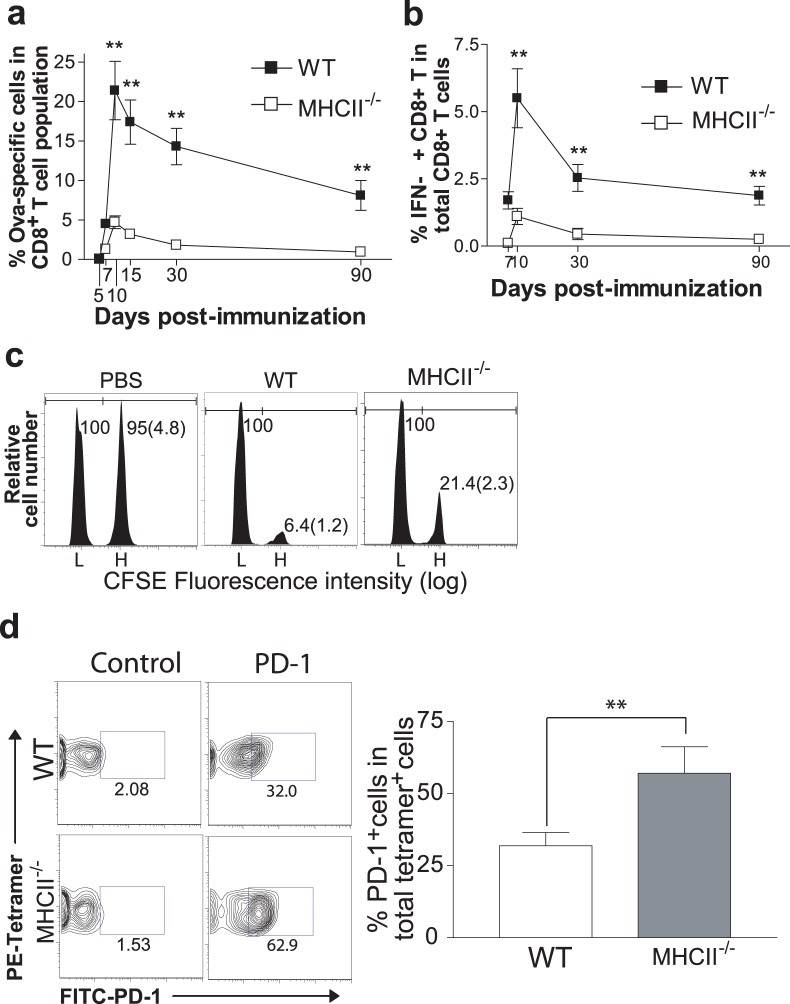
CD4+ T cells impact the kinetics of AdV transgene-specific CTL populations.Following immunization, AdVova-specific CTLs were analyzed in the peripheral blood at different time points by tetramer (a) and intracellular IFN-γ (b) stainings. The values are presented as mean%±SD of OVA-specific tetramer+ CTLs (a) or IFN-γ+ CTLs (b) in total CD8+ T cell population and are representative of two to three independent experiments with three to four mice per group. **P<0.01, versus MHCII−/− mice. (c) Ten days following immunization, the proportions of CFSEhigh-OVAI-pulsed target cells lysed by effector CTLs were determined in the spleens by in vivo cytotoxicity assay. The values represent mean %±SD of targets remaining in spleens relative to controls and are representative of two independent experiments with three to four mice per group. (d) On day 75, following immunization, OVA-specific memory CTLs were characterized in spleen for PD-1 expression by flow cytometry. A representative figure from immunized groups along with matching isotype control is shown on the left. The values in the bar diagram represent the mean %±SD of PD-1+ tetramer+ CTLs in total tetramer+ CTL population and are representative of two independent experiments with 3 to 4 mice per group. **P<0.01, versus WT mice.